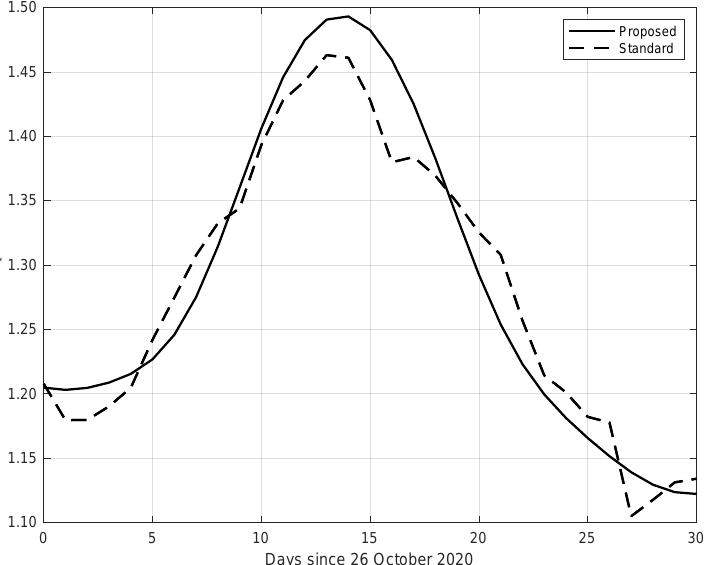
Figure 11. Sequence of the reproduction number R t for real SARS-CoV-2 data in New York city, from 26 October to 25 November 2020. The continuous line corresponds to the proposed method, while the dashed line corresponds to the standard